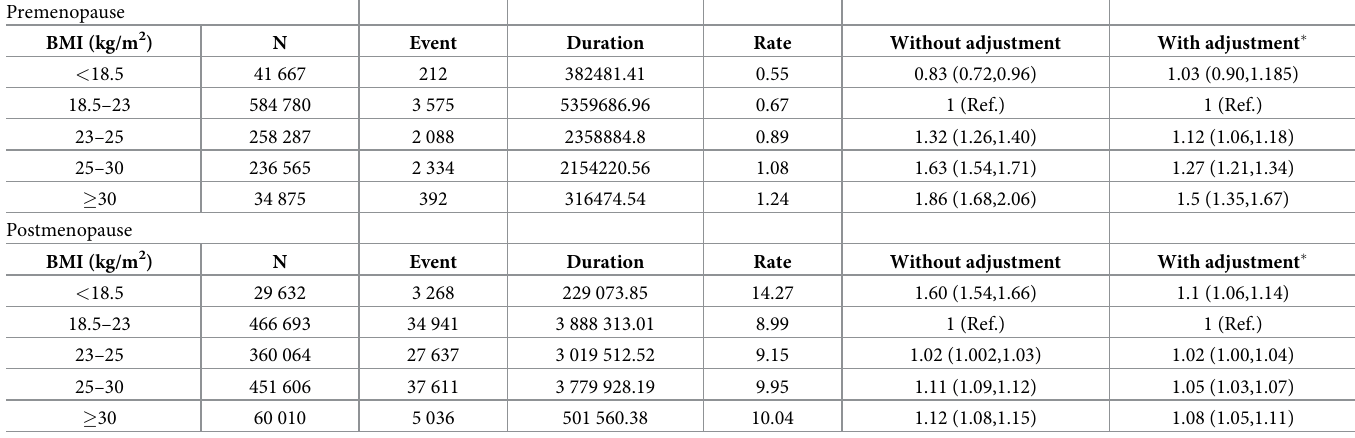
Table 5. Cox proportional hazards regression analysis for the development of vertebral fracture according to BMI in the premenopausal and postmenopausal groups. Premenopause